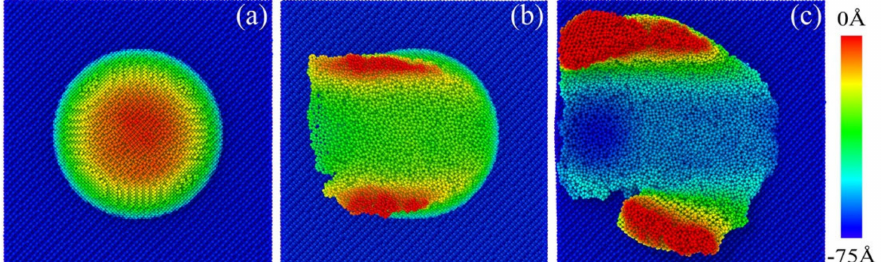
Figure 16. Surface morphology from different plowing depths: ( a ) no ductile ploughing was ob- served at 2 nm plow depth, ( b ) symmetrical plastic flow pile-up occurred at 4 nm plow depth and ( c ) significant crack propagation at 7 nm plow depth. The images were colored according to the height of the atomic